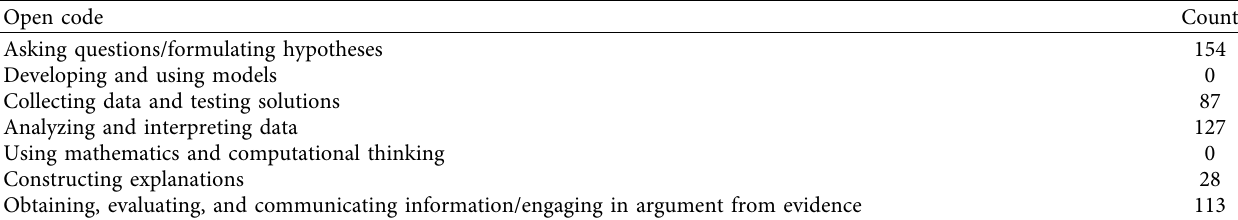
Table 3: Open codes associated with scientific